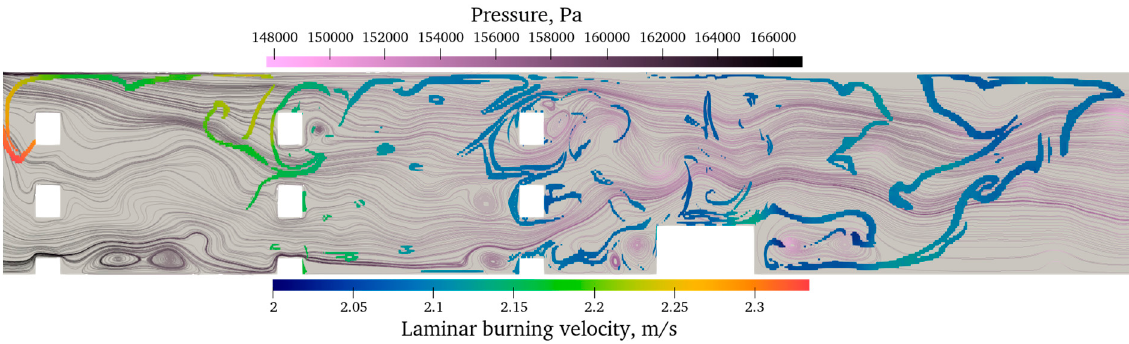
Figure 14. Simulated LBV and pressure distributions in the vented chamber at a selected moment.